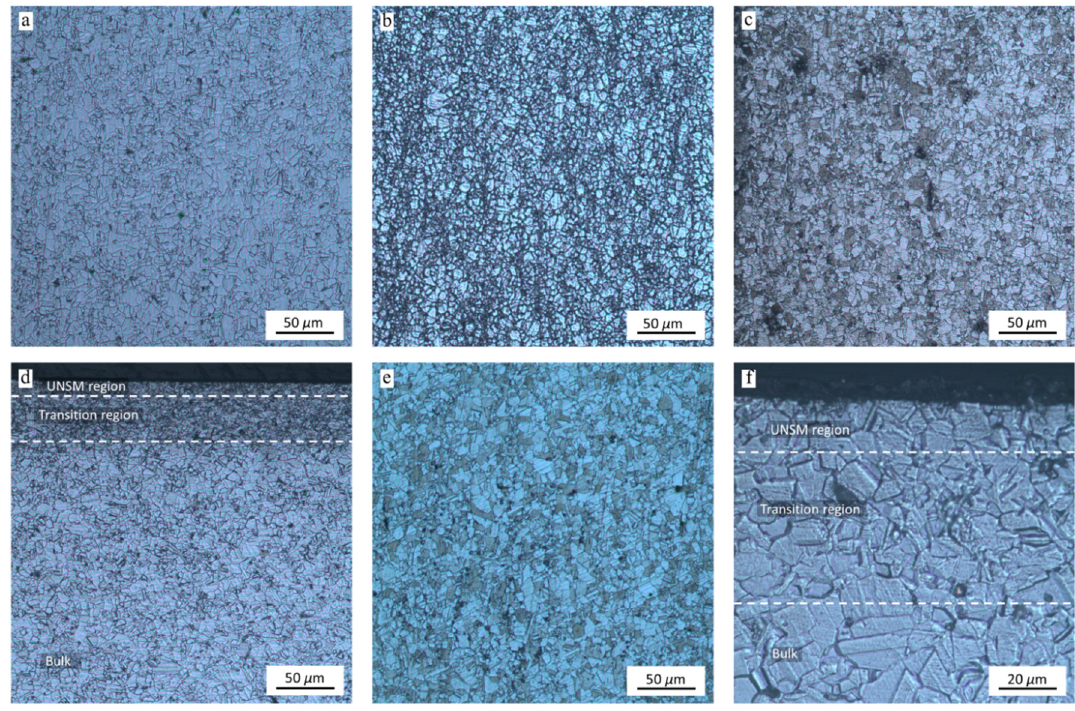
Figure 7. Optical microscope images showing the cross-section microstructure of Inconel 718: ( a ) As-received sample (×10), ( b ) I1 sample (×10), ( c ) I2 sample (×10), ( d ) I3 sample (×10), ( e ) I4 sample (×10) and, ( f ) I4 UNSM region (×50).